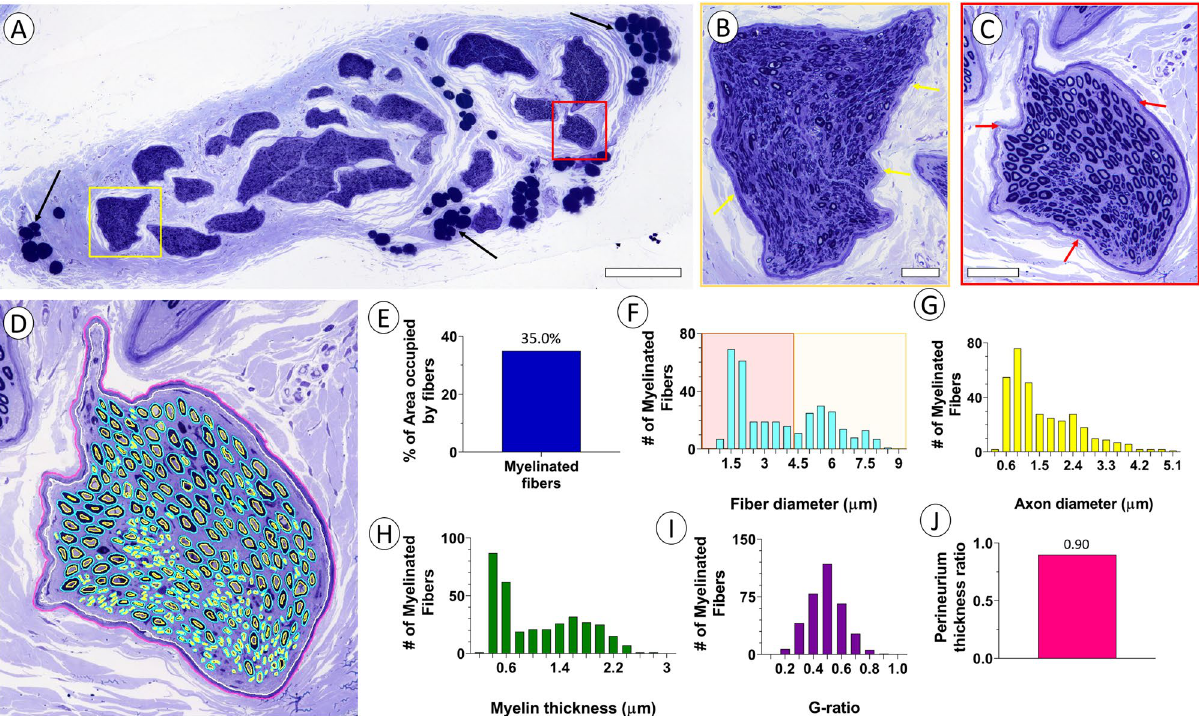
Figure 1. Light micrographs of human cervical vagus nerve. ( A ) LM overview of a representative cervical vagus nerve from a 49 year old female. Note multiple fascicles surrounded by loose connective tissue and lipid droplets (arrows). Scale bar = 500 µm. ( B , C ) Detailed view of individual fascicles indicated by yellow and red boxes in ( A ). Note distinct perineurium forming distinct boundary of each fascicle (arrows) and presence of numerous myelinated axons within each fascicle. Scale bars = 50 µm. ( D ) Fascicle in ( C ) after segmentation of the inner and outer contours of myelinated axons (n = 345) and perineurium. Quantitative information in ( E – J ) are derived from contoured structures in ( D ). ( E ) Histogram of percent of fascicle area inside of perineurium occupied by myelinated axons. ( F – H ) Size distribution of myelinated fiber diameter, axon diameter, and myelin thickness, respectively. Note two distribution peaks suggesting two distinct populations of myelinated fibers. ( I ) Distribution of G-ratios for myelinated fibers. ( J ) Histogram of perineurium thickness of the endoneurium space in the transverse plane (Fig. 3E). The myelinated fiber diameter and axon diameter were 1.75 ± 0.08 µm and 0.74 ± 0.05 µm, respectively, and a size distribution display showed all fibers within the 0–4 µm myelinated fiber diameter range (Fig. 3F, G). The myelin thickness was 0.50 ± 0.03 µm (Fig. 3H), and the G-ratio was 0.35 ± 0.04 (Fig. 3I). The perineurium thickness ratio was 0.80 (Fig. 3J). Ultrastructural studies of the abdominal and gastric vagus nerve segments confirmed the presence of a relatively sparse population of myelinated axons with excellent myelin sheath preservation and well-preserved axonal cytoskeleton, including neurofilaments and microtubules. A large number of unmyelinated fibers dominated the endoneurium space and, together with Schwann cells, formed Remak bundles (Fig. 3K, L). An abundance of collagen fibers was interspersed between the fibers and Schwann cells. To show feasibility for using human organ-donor derived vagus nerve samples for quantitative analysis of fiber size and myelination, electron micrographs of representative areas were obtained from representative cervical and abdominal portions the vagus nerve and tiled, followed by computer-supported manual segmentation of myelinated and unmyelinated fibers and Schwann cell nuclei within the region of interest (Fig. 4A, B, D, E). For the cervical vagus nerve sample, the region of interest occupied by myelinated fibers (n = 7) and unmyelinated axons (n = 92) was 15.2% and 18.5%, respectively (Fig. 4C). In contrast, the region of interest for the abdomi- nal vagus nerve occupied by myelinated fibers (n = 1) and unmyelinated axons (n = 170) was 1.1% and 21.8%, respectively (Fig. 4F). For the cervical vagus nerve, the myelinated fiber and axon diameters were 1.43 ± 0.08 µm and 0.50 ± 0.06 µm, respectively (Fig. 4C). The myelin thickness and G-ratio were 0.47 ± 0.04 µm and 0.35 ± 0.04, respectively. The unmyelinated fiber diameter was 0.52 ± 0.02 (Fig. 4C). For the abdominal vagus nerve, the sin- gle myelinated fiber and axon diameters were 3.20 µm and 1.96 µm, respectively Fig. 4F). The myelin thickness was 0.62 µm and the G-ratio was 0.61 (Fig. 4F). The unmyelinated fiber diameter was 0.89 ± 0.03 µm (Fig. 4F). The total number of nerve fibers in cervical and abdominal branches of the human vagus nerve was cal- culated by extrapolating the number of segmented myelinated and unmyelinated axons in a region of interest (ROI) from a representative fascicle at each nerve biopsy site. There was extensive variability in the number of fibers at both the cervical and abdominal sites (Table 1). The total number of nerve fibers in the cervical vagus was 111,984 ± 19,217 (n = 7) and not significantly different from the corresponding total number nerve fibers of 82,861 ± 19,217 in the abdominal vagus (n = 5; Fig. 5A). The number of myelinated fibers in the cervical vagus